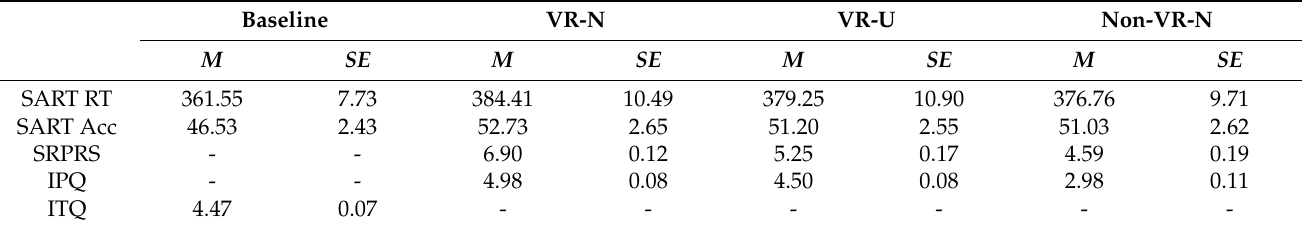
Table 2. Descriptive statistics for restorativeness (SART, SRPRS), presence (IPQ) and immersive tendencies (ITQ) measures for 120